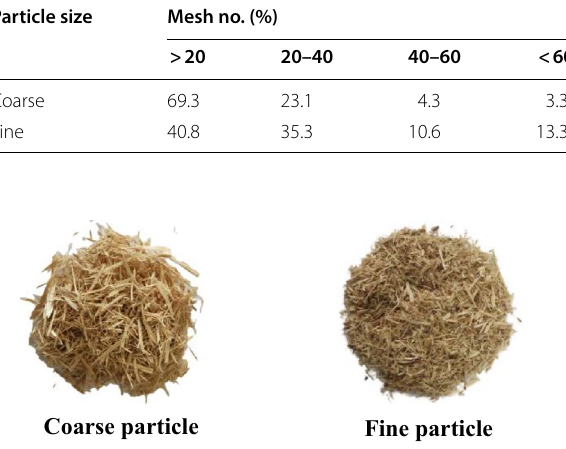
Fig. 1 Broussonetia papyrifera